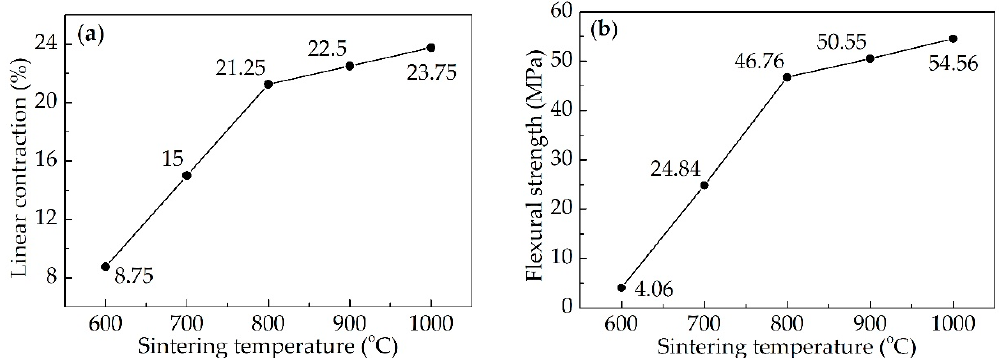
Figure 4. Properties of the ceramic samples sintered at different temperatures: ( a ) linear contraction; ( b ) flexural strength.